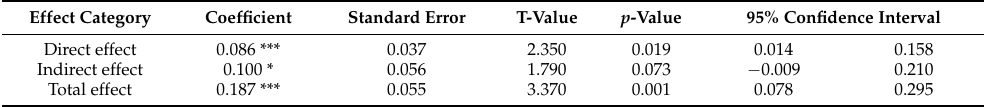
Table 7. Adjacency weight matrix.